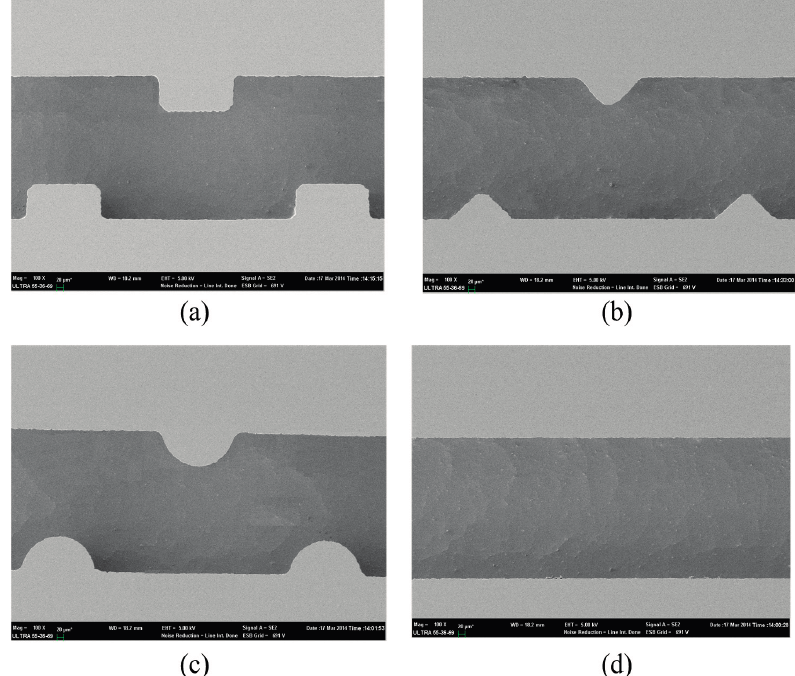
Figure 4. The SEM of ( a ) the rectangular ribbed microchannel, ( b ) the triangular ribbed microchannel, ( c ) the semicircular ribbed microchannel and ( d ) the smooth microchannel.